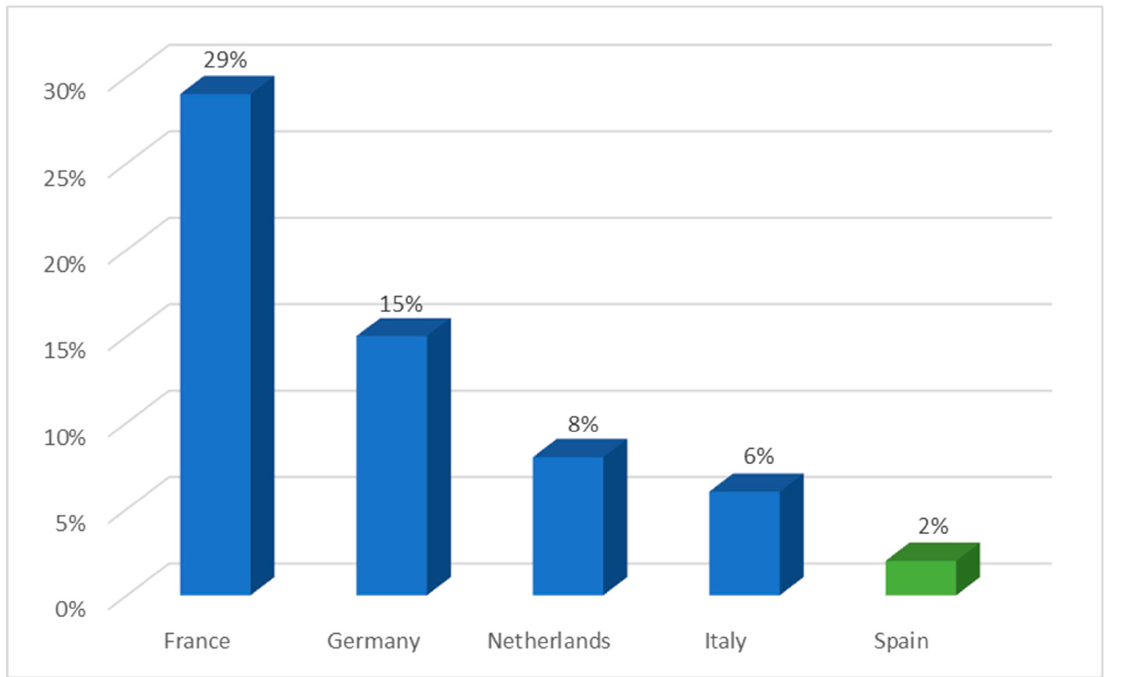
Figure 1. Percentage of farms in which their owners have completed higher education related to agriculture (2013) [16]. In this case, higher education is defined as any training cycle that has a duration equivalent to at least two full-time years after the end of compulsory schooling and that has been completed at university or any other agricultural training center.